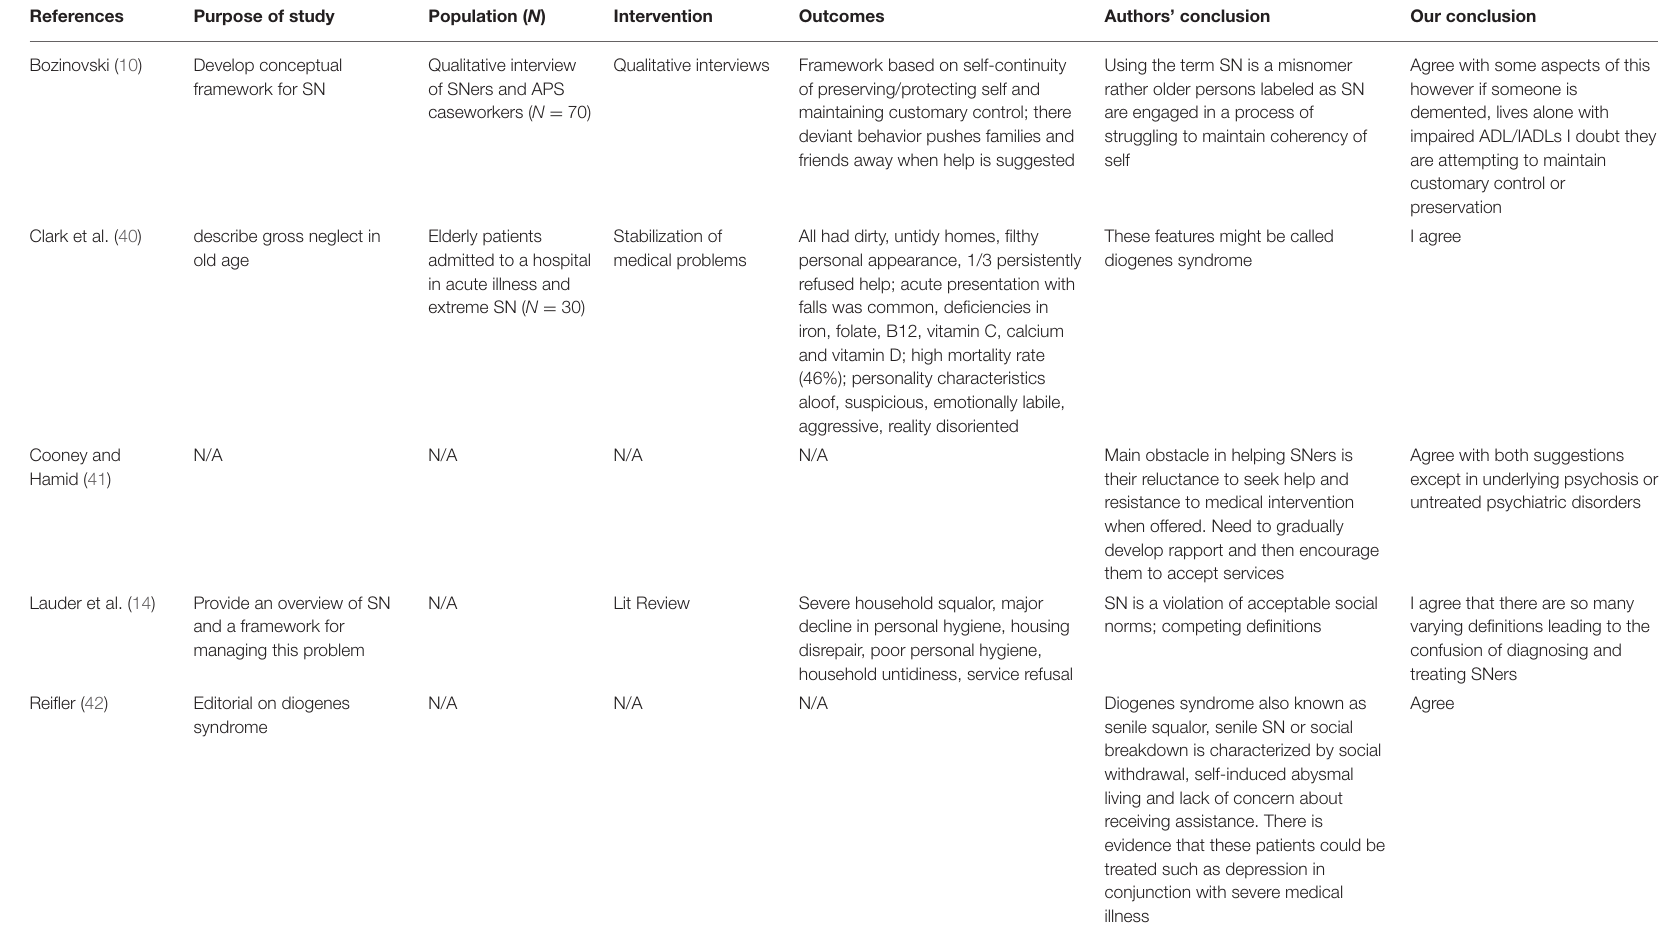
TABLE 4 | Refusing intervention increases